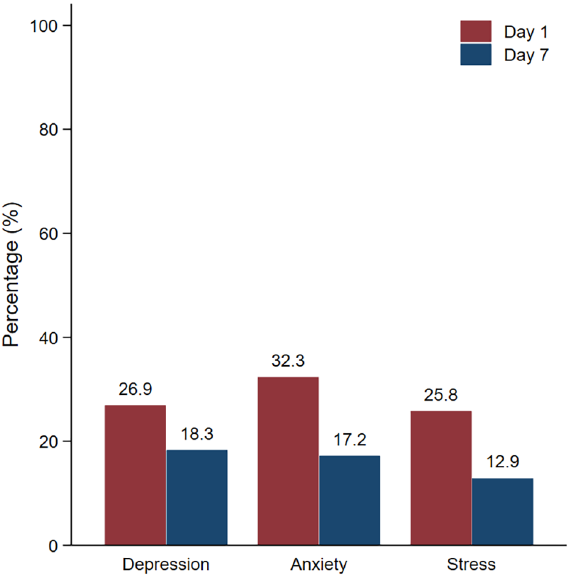
Figure 1. Prevalence of mental health problems on day 1 and day